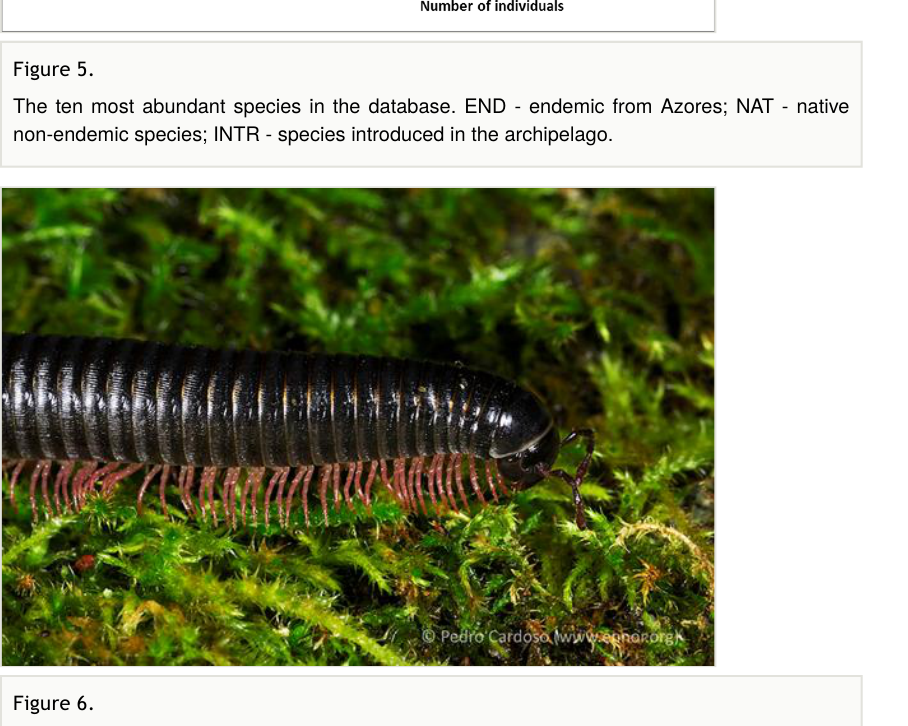
The millipede Ommatoiulus moreletii (Credit: Pedro